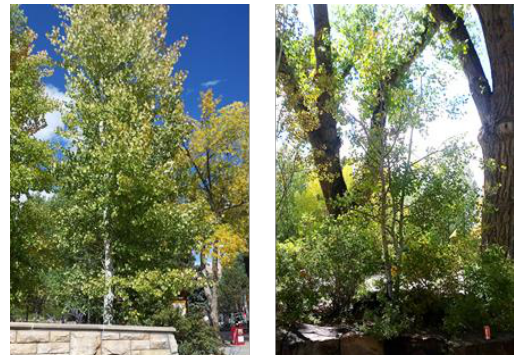
Figure 1. Some of the aspen trees growing in the University of Wyoming campus in Laramie, WY (USA). Some trees received sunlight most of the day (left) while others were shaded by trees and buildings